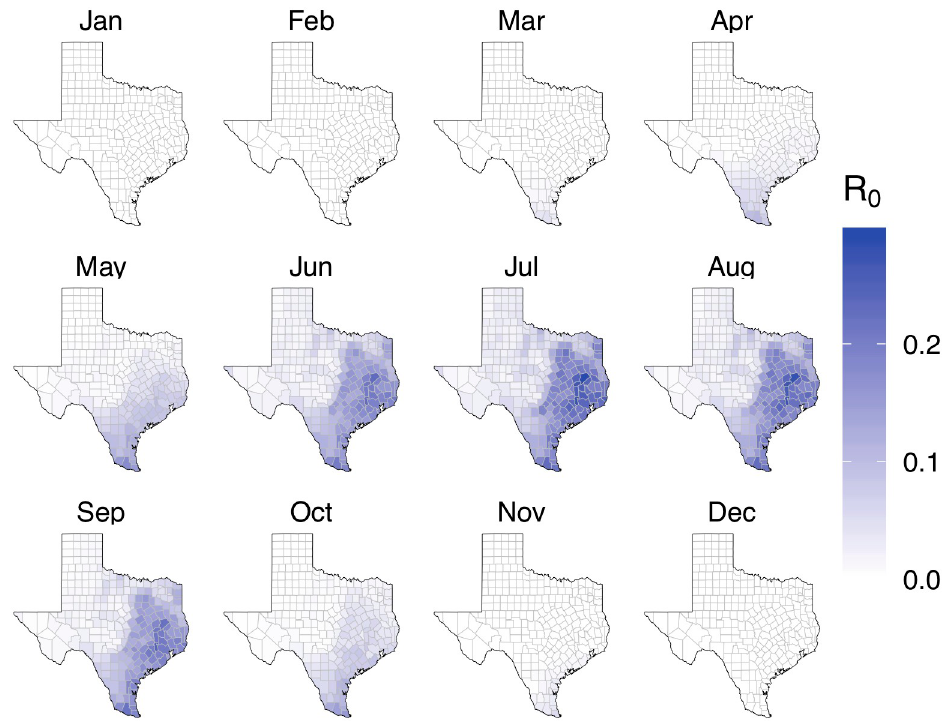
Fig 2. Posterior median county R 0 estimates for Texas, based on ZIKV importations through January 2017. This assumes that all importations were terminal except for two autochthonous cases detected in Cameron County in late